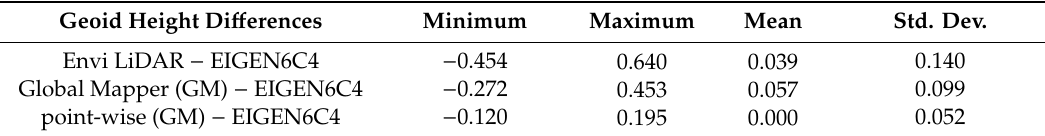
Table 5. Statistics of geoid height differences between local geoid models (Envi LiDAR and Global Mapper, respectively) and global geoid (EIGEN6C4) (m).